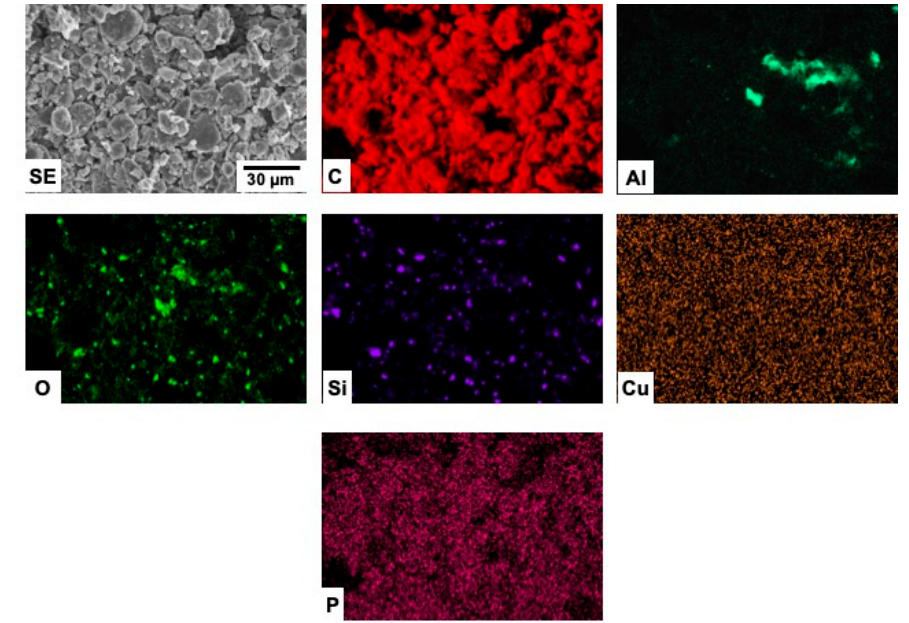
Figure 6. SEM-EDX mappings from sample C-L 1 BM.